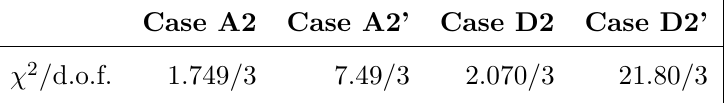
Table 6 . Best Fit Point (cid:31) 2 for a hypothetical future (cid:18) 23 measurement. Corresponding best (cid:12)t parameters shown in table